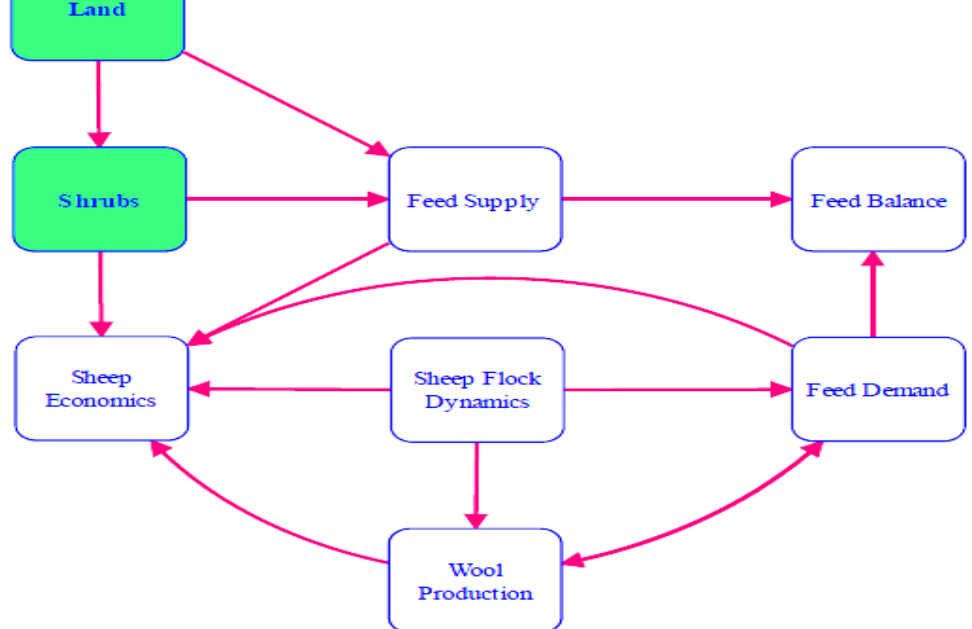
Figure 1. A simplified diagram of the North Island hill country sheep and beef whole farm system dynamic model comprising modules of the hill country sheep enterprise (HCM) (white fill based on Farrell et al. (2019) and native shrub (NSM) models (green fill)). The arrows indicate the direction of interaction among the modules.